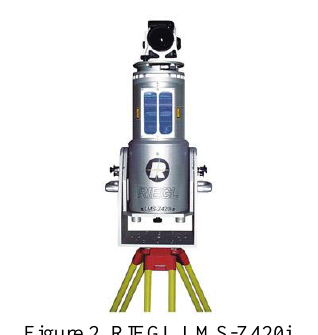
Figure 2. RIEGL LMS-Z420i A set of cylinder targets were deployed to register the TLS data as tie points. Scans of the remaining shapes were acquired from five positions (Fig. 3). The distance between the object and different positions was in the range of 4-6 meters. The resolution (point spacing on the object surface) was set to 0.0024mm (@4m) resp. 0.0036mm (@6m).